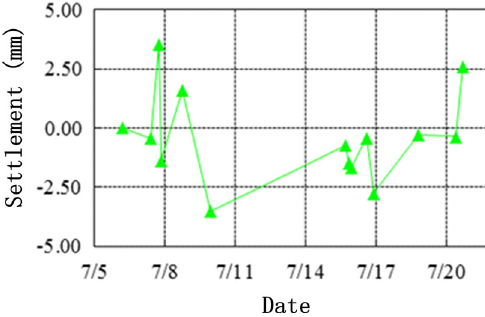
Fig. 5 Cumulative amount of settlement at test